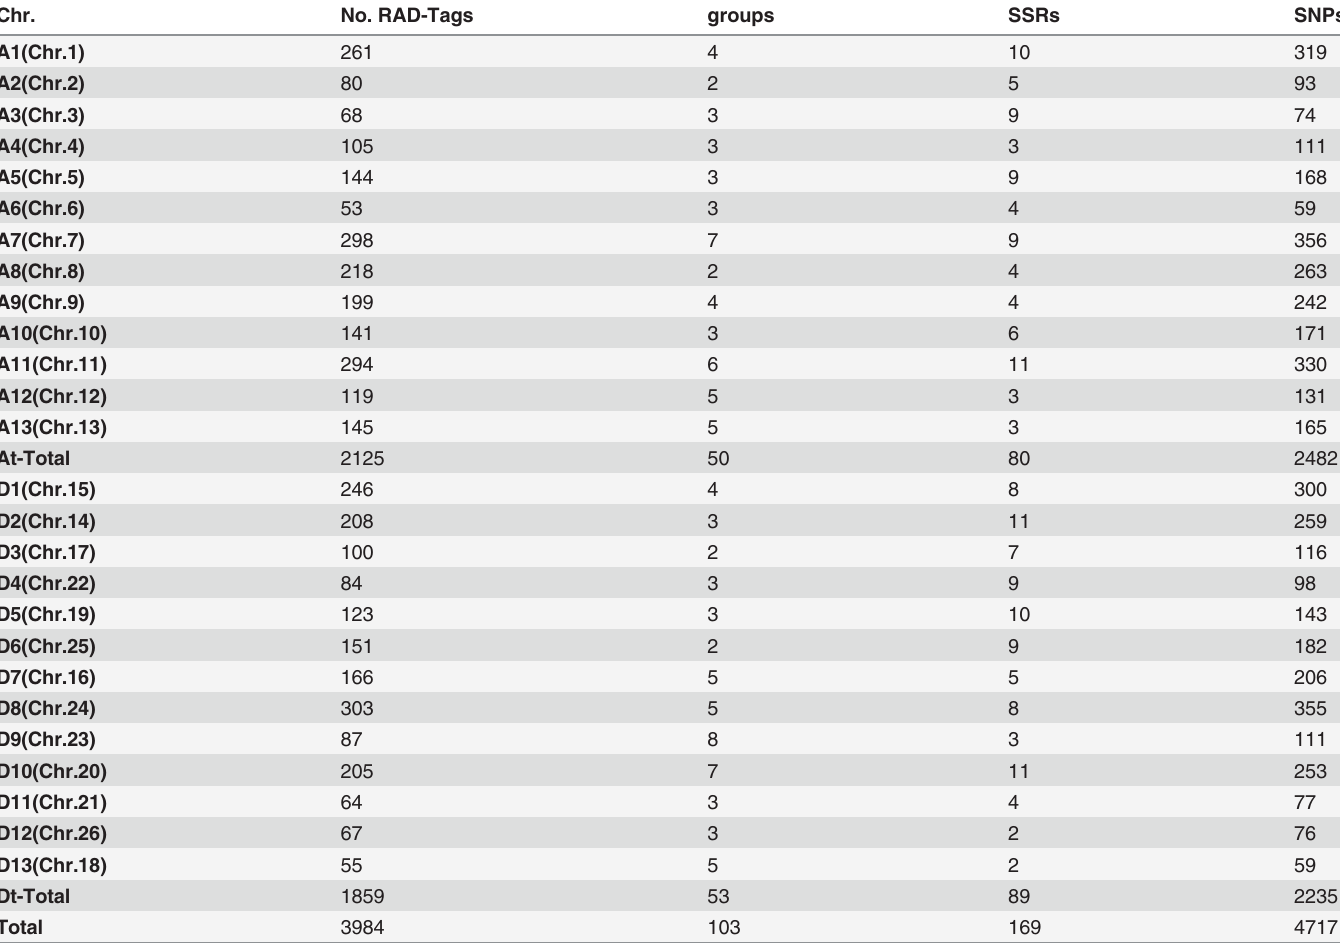
Table 3. The information of chromosome in the genetic map based on SNPs of tetraploid cotton.